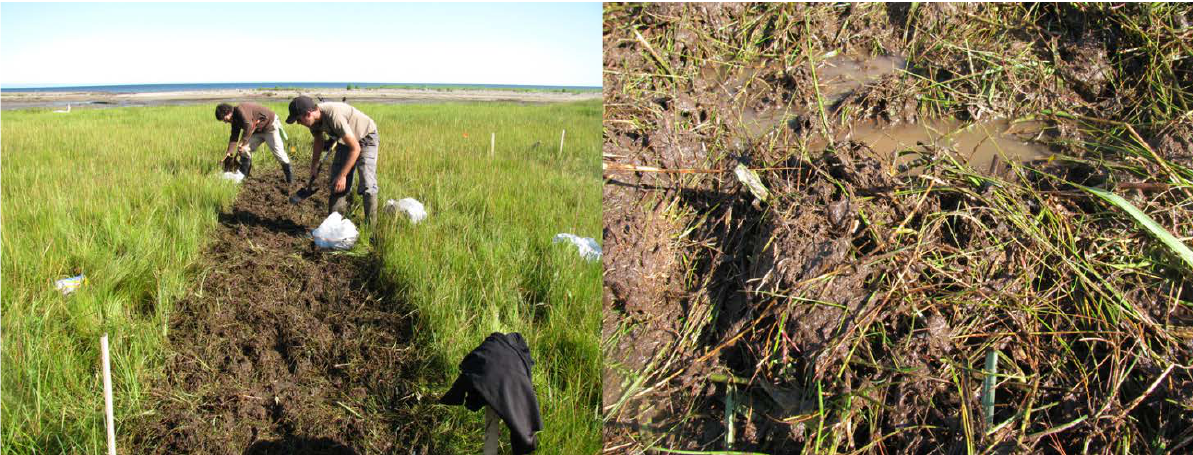
Figure 1. Collection of diaspore material from the salt marsh at Pokesudie. The material was collected by hand after a rototiller had been passed over the donor area (left). The picture on the right is a close-up of the diaspore material, which includes the aerial parts of the vegetation and 5 cm of salt marsh